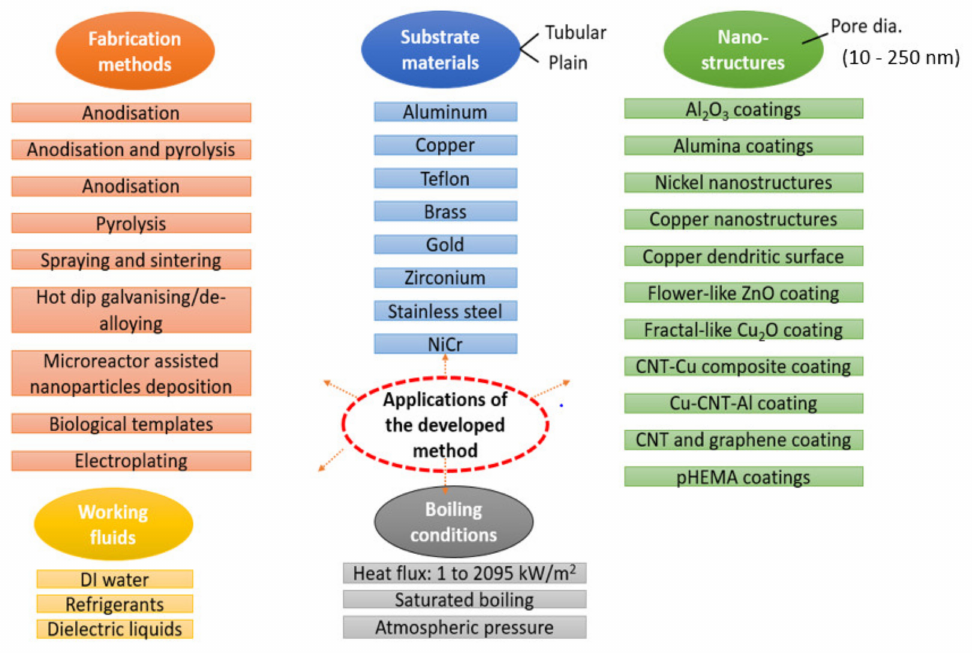
Figure 14. Applications of the proposed